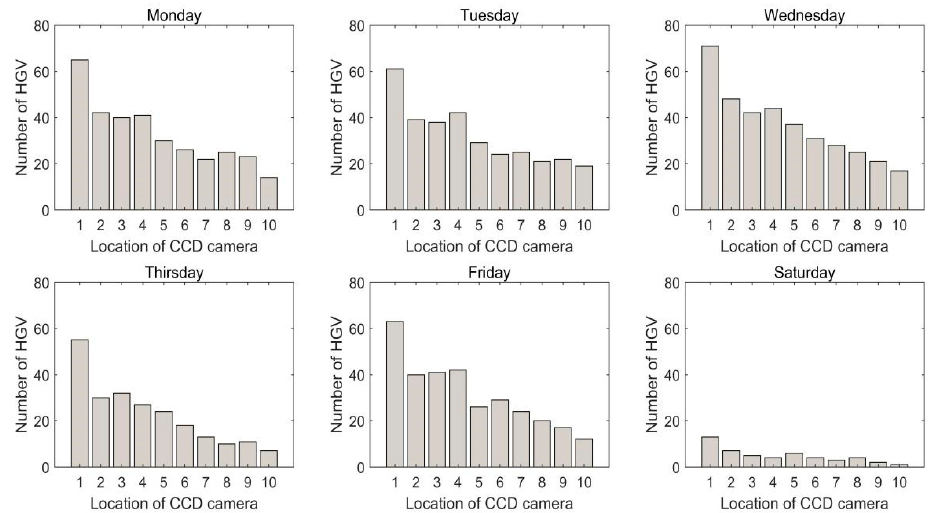
Figure 10. The number of hazardous goods vehicles of different position from Monday to Saturday.